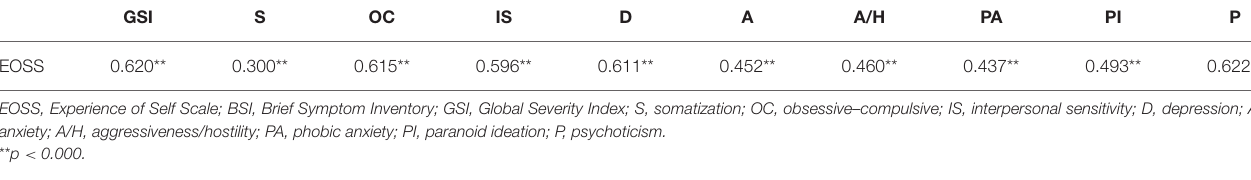
TABLE 2 | Pearson correlations between the EOSS and the BSI subscales. GSI S OC IS